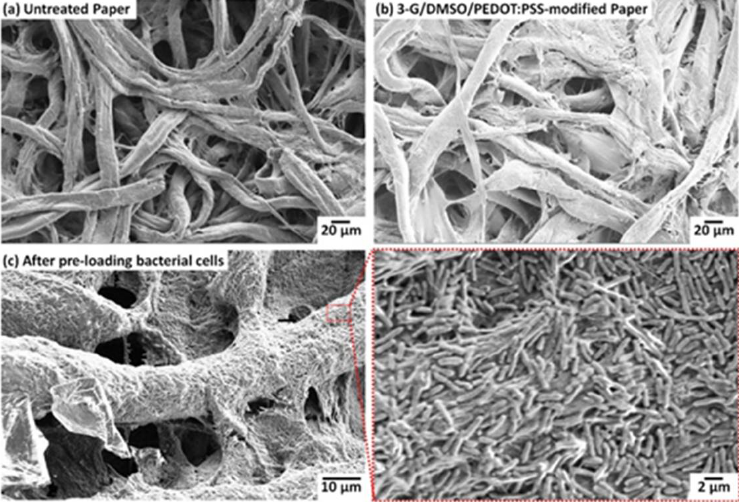
Figure 3. SEM (Scanning electron microscope) images of the anodic chamber. ( a ) Non-treated paper and 3-G/DMSO/PEDOT:PSS-treated paper ( b ) without and ( c ) with bacterial cells. 3-G: 3-glycidoxypropy-trimethoxysilane; DMSO: dimethyl sulfoxide; PEDOT:PSS: poly(3,4-